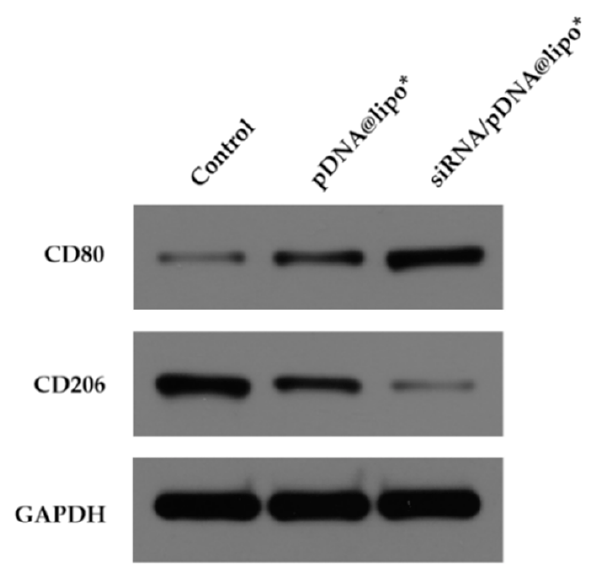
Figure 8. Western blot analysis of CD80 and CD206 of J774A.1 cells treated with different complexes for 48 h at the siRNA concentration of 300 pmol/mL and/or the pIL-12 concentration of 5 µ g/mL. J774A.1 cells without treatment were used as a control.